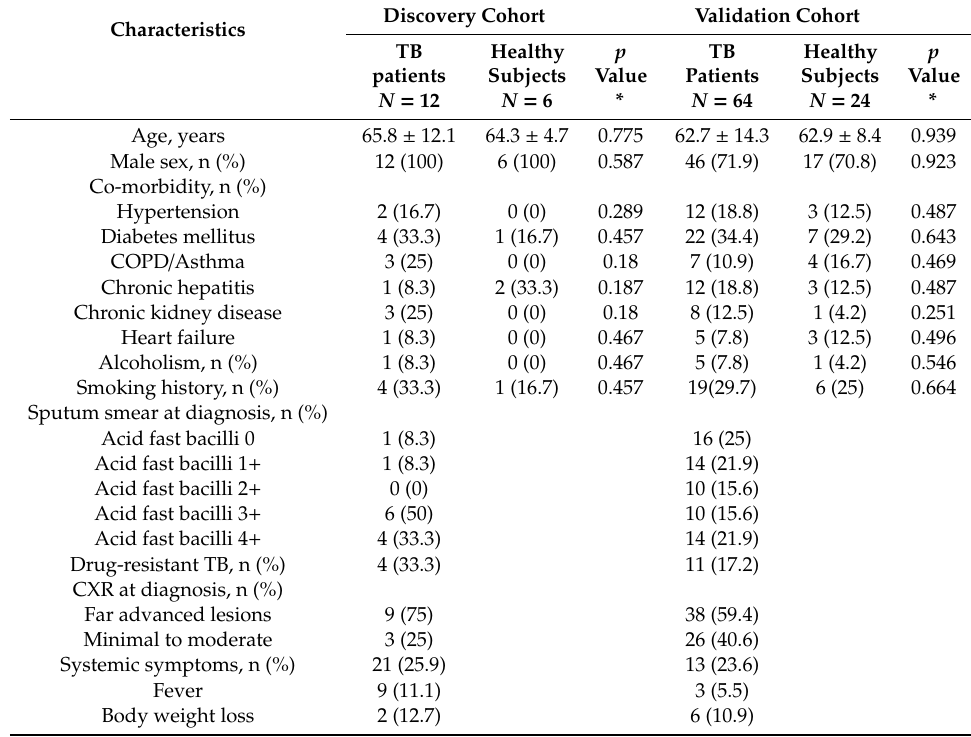
Table 1. Demographic and clinical characteristics in the sputum culture positive pulmonary tuberculosis (TB) patients and healthy subjects in the discovery and validation